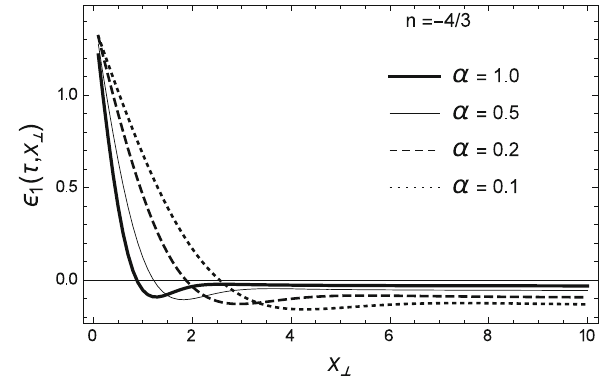
Fig. 21 (cid:5) 1 (τ, x ⊥ ) as a function of x ⊥ for different values of α at τ 0 = 1 fm